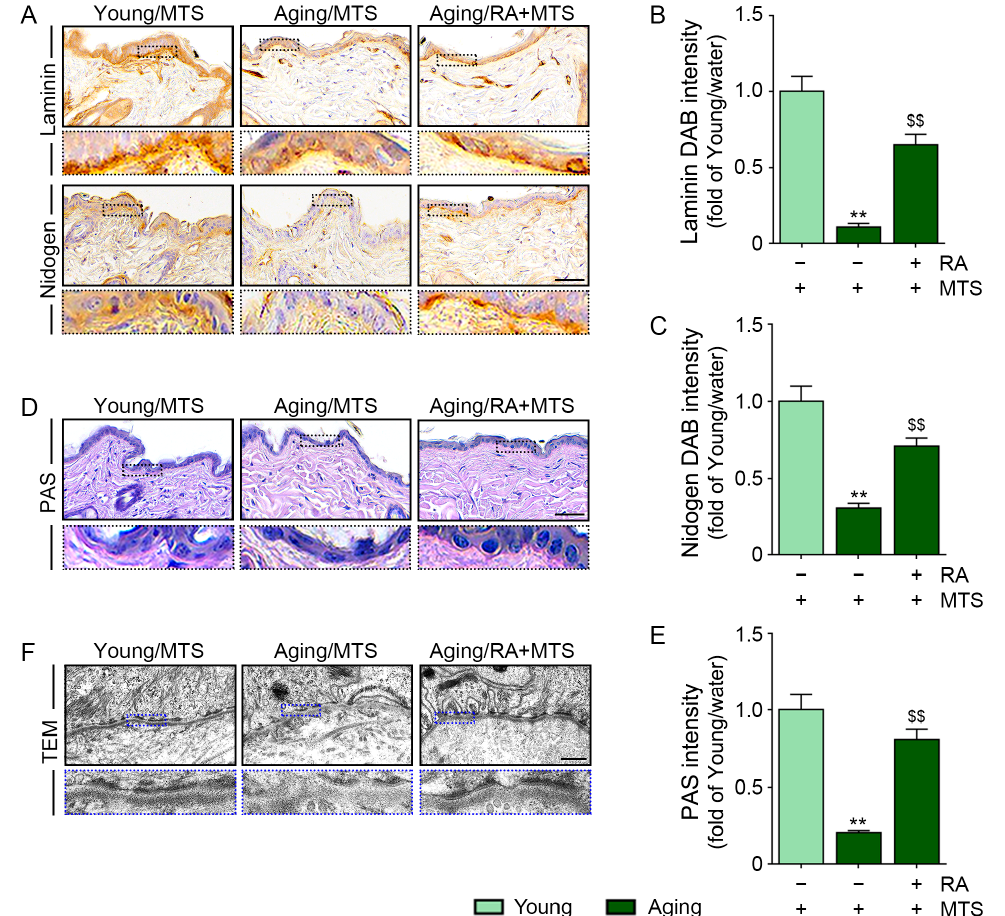
Figure 5. RA treatment restored the BM condition in aged mouse skin. ( A–C) Laminin and nidogen expression was confirmed by immunochemistry (scale bar = 50 μ m). The intensities of the laminin ( B ) and nidogen ( C ) signals were decreased in aged mouse skin but increased by RA injection. ( D, E ) BM density was confirmed by PAS staining (scale bar = 50 μ m). The PAS staining intensity was decreased in aged mouse skin but increased by RA injection. ( F ) The BM condition was confirmed by transmission electron microscopy (scale bar = 5 μ m). The hemidesmosomes and lamina densa in TEM images were restored by RA injection. The data are presented as the mean ± SD of three independent experiments. **, p < 0.01, second bar vs. first bar; $$, p < 0.01, third bar vs. second bar (Mann–Whitney U test). BM; basement membrane, DAB; 3,3 ′ -diaminobenzidine tetrahydrochloride hydrate, PAS; periodic acid-Schiff, TEM; transmission electron microscopy.